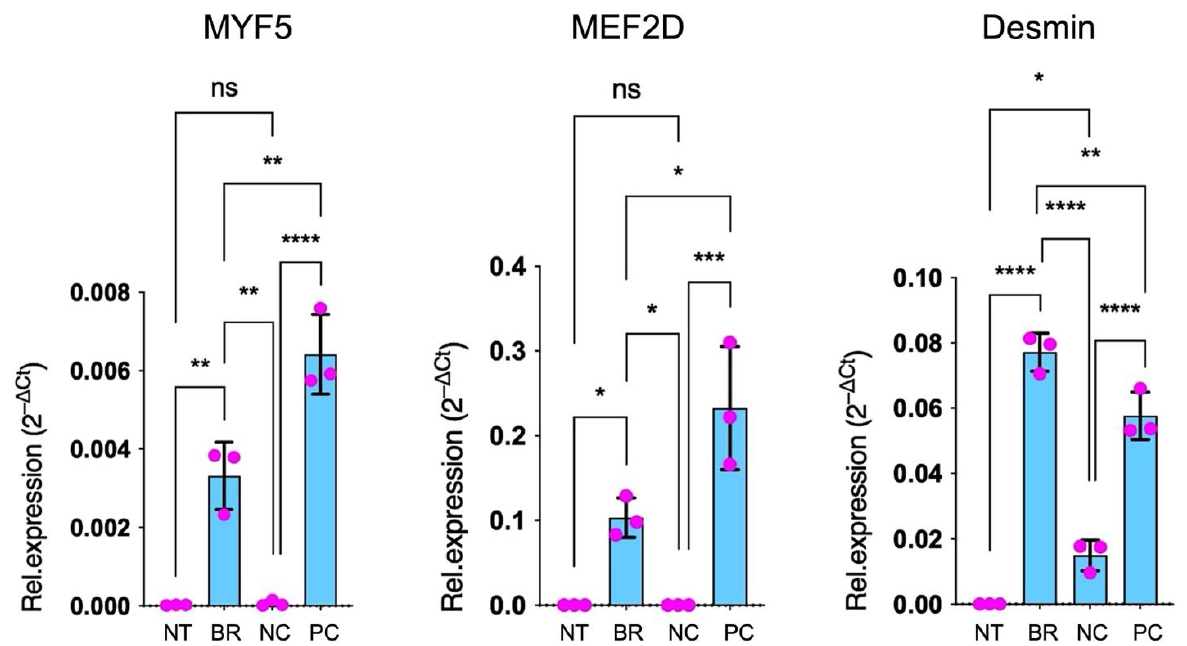
Figure 5. qPCR for the analysis of specific genetic marker expression (MYF5, MEF2D, desmin) for myoblast differentiation. Cell-seeded scaffolds were cultured for two weeks in the absence of a bioreactor as a negative control (NC) and in the bioreactor (BR), and murine blood vessels were utilized as a positive control (PC) in three independent experiments (error bars denote the standard error of the mean, ns = p > 0.05, * = p ≤ 0.05, ** = p ≤ 0.01, *** = p ≤ 0.001 and **** = p ≤ 0.0001).